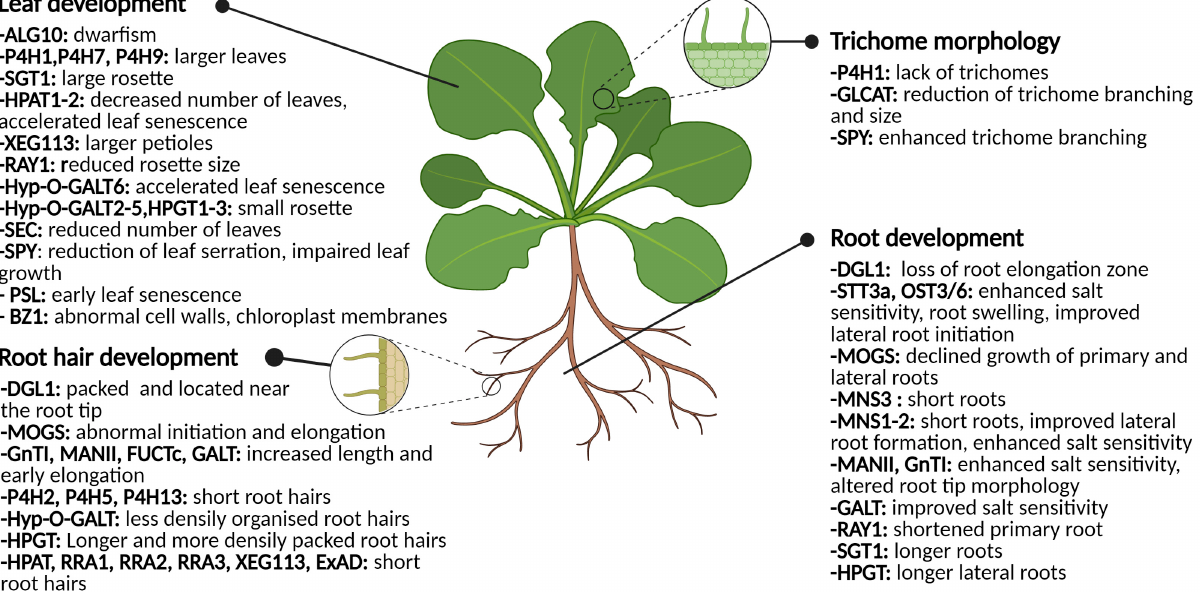
Figure 5. Graphical representation of the glycosylation-related enzymes and their role in leaf development, trichome mor- phology and root (hair) development. Both abnormal N-glycosylation and O-glycosylation result in changes of phenotype and morphology. Abbreviations: ALG10 ( α -1,2-glucosyltransferase 10), BZ1 (Brittle stem and Zebra Leaf 1), DGL1 (DE- FECTIVE IN GLYCSOYLATION1), ExAD (extensin arabinose deficient transferase), FUCTc ( α 1,4-fucosyltransferase), GALT ( β 1,3-galactosyl-transferase), GLCAT ( β -glucuronosyltransferases), GnT1 (N-acetylglucosaminyltransferase I), HPAT1-2 (Hyp O-arabinosyltransferases 1 and 2), HPGT (Hydroxyproline O-galactosyltransferase), Hyp-O-GALT (hy- droxyproline-O- β -galactosyltransferase), MANII ( α -mannosidase II), MNS ( α -mannosidase I), MOGS (mannosyloligosac- charide glucosidase), OST3/6 (oligosaccharyltransferase subunit 3/6), P4H (prolyl 4-hydroxylase), PSL (premature senes- cence leaf), RAY1 (REDUCED ARABINOSE YARIV1), RRA (REDUCED RESIDUAL ARABINOSE), SEC (SECRET AGENT), SGT (serine O- α -galactosyltransferase), SPY (SPINDLY), STT3a (STAUROSPORIN AND TEMPERATURE SEN- SITIVE3A), XEG113 (Xylo-endoglucanase113). This figure was created with BioRender.com.